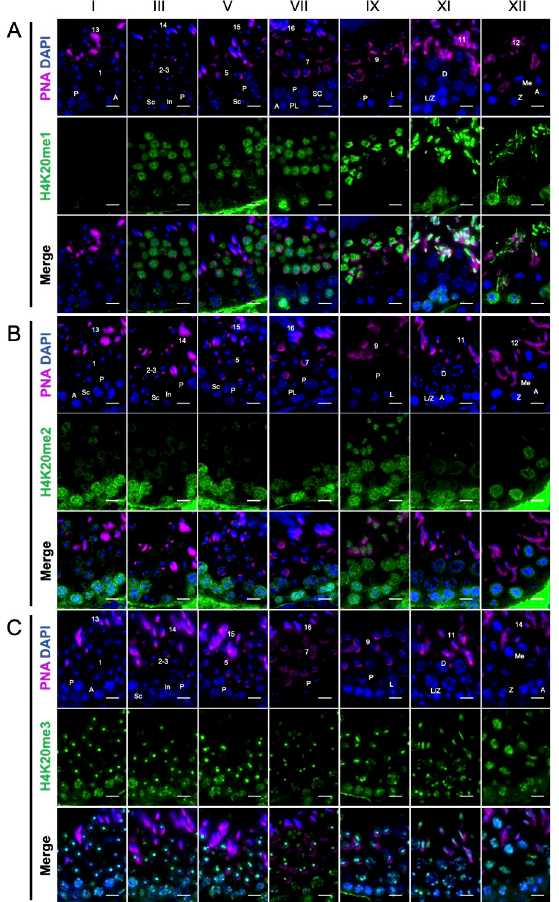
Fig 1. The distribution of trimethylated H4K20 in the seminiferous tubule. The distributions of nucleus and acrosomes (DAPI, blue; PNA, magenta: Top panels), tri-methylated (A), di-methylated (B), and mono-methylated (C) H4K20 (green: Middle panels), and merged images (bottom panels) in the stages I, III, V, VII, IX, XI, and XII are shown. A, type A spermatogonia; PL, preleptotene spermatocyte; L, leptotene spermatocyte; Z, zygotene spermatocyte; P, pachytene spermatocyte; Sc, Sertoli cells; Numbers, step of post-meiotic germ cells. Scale bars = 10 μ